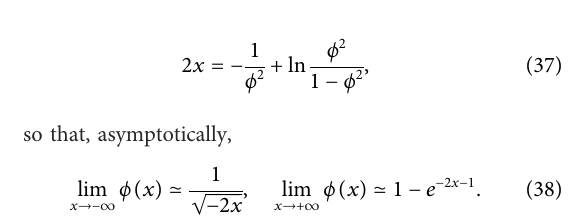
FIGURE 3 Potential given by Eq. 40 with n = 1 ( V 1 ) and n = 2 ( V 2